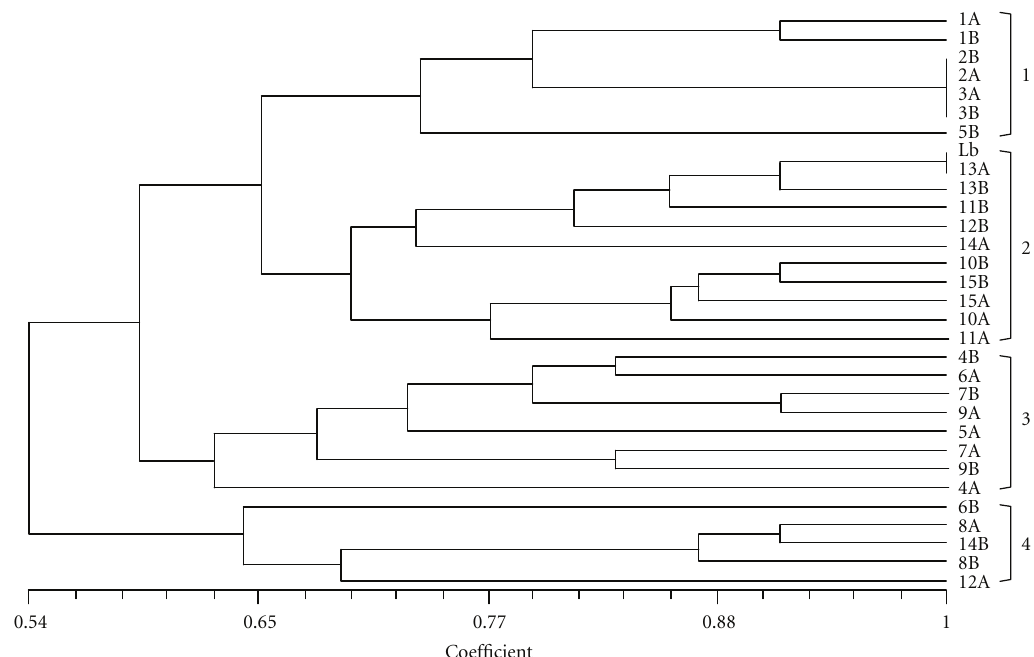
Figure 1: UPGMA dendrogram based on the LSSP-PCR profiles of samples isolated from lesion before treatment (A) and after reactivation (B). Lb: L . ( V .) braziliensis reference